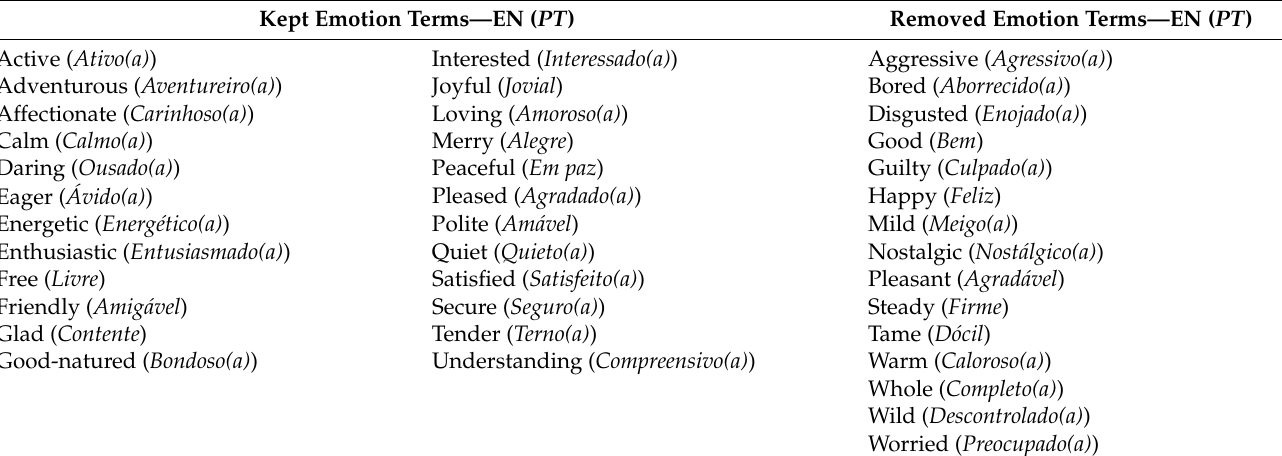
Table 3. List of emotion terms used in both experiments. In parenthesis, the Portuguese version as it was used for both experiments (from Cunha [50]); the (a) at the end of some terms represents the masculine/feminine gender-specific variation (e.g., Ativo(a) reads as Ativo / Ativa ).